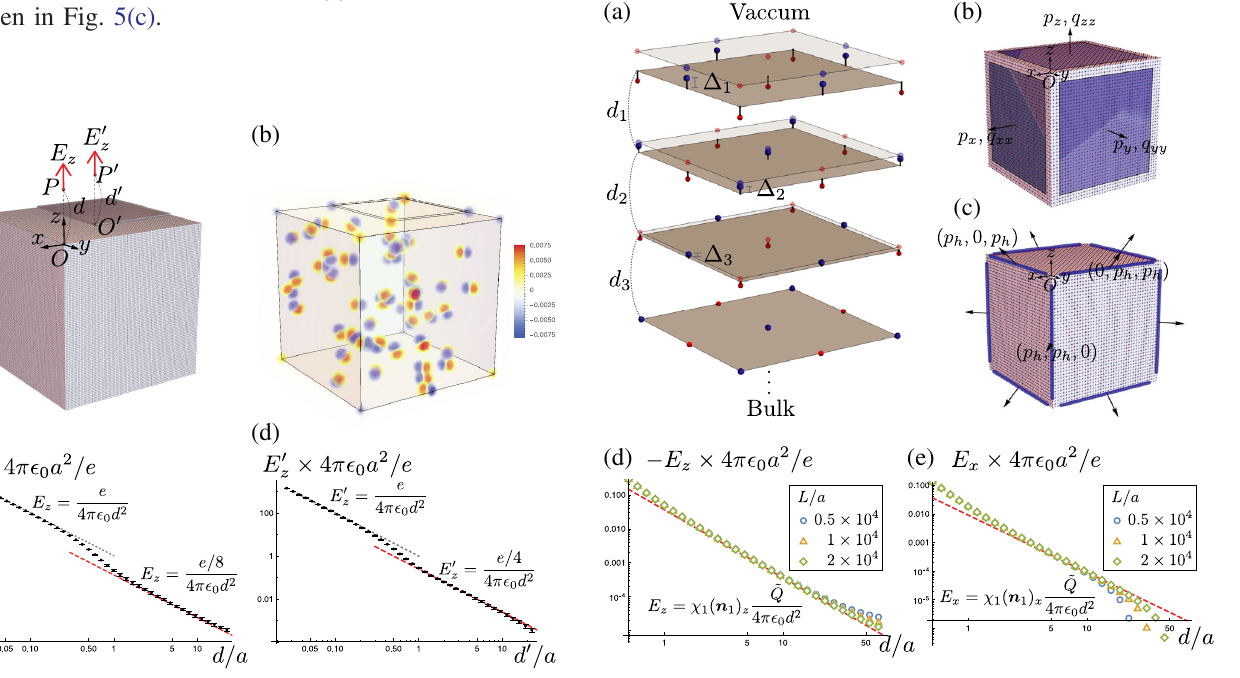
FIG. 6. (a) The surface relaxation of the (001) surface of NaCl. The scales are exaggerated for illustration. (b) Out-of-plane dipole moments and quadrupole moments induced near surface. (c) Dipole moments induced on hinges. (d) The contribution to the z component of the electric field from the surface relaxation. We use the experimental values [50] of Δ 1 ¼ 0 . 07 Å, Δ 2 ¼ 0 . 01 Å, Δ ¼ 0 , d ¼ 2 . 76 Å, d ¼ 2 . 80 Å, and d ¼ 2 . 81 Å, which 3 1 2 3 ˜ Q ¼ − 0 give . 036 e . The red dashed line represents the ana- lytic expression in Eq. (18). (e) The same as (d) but for the x component of the electric